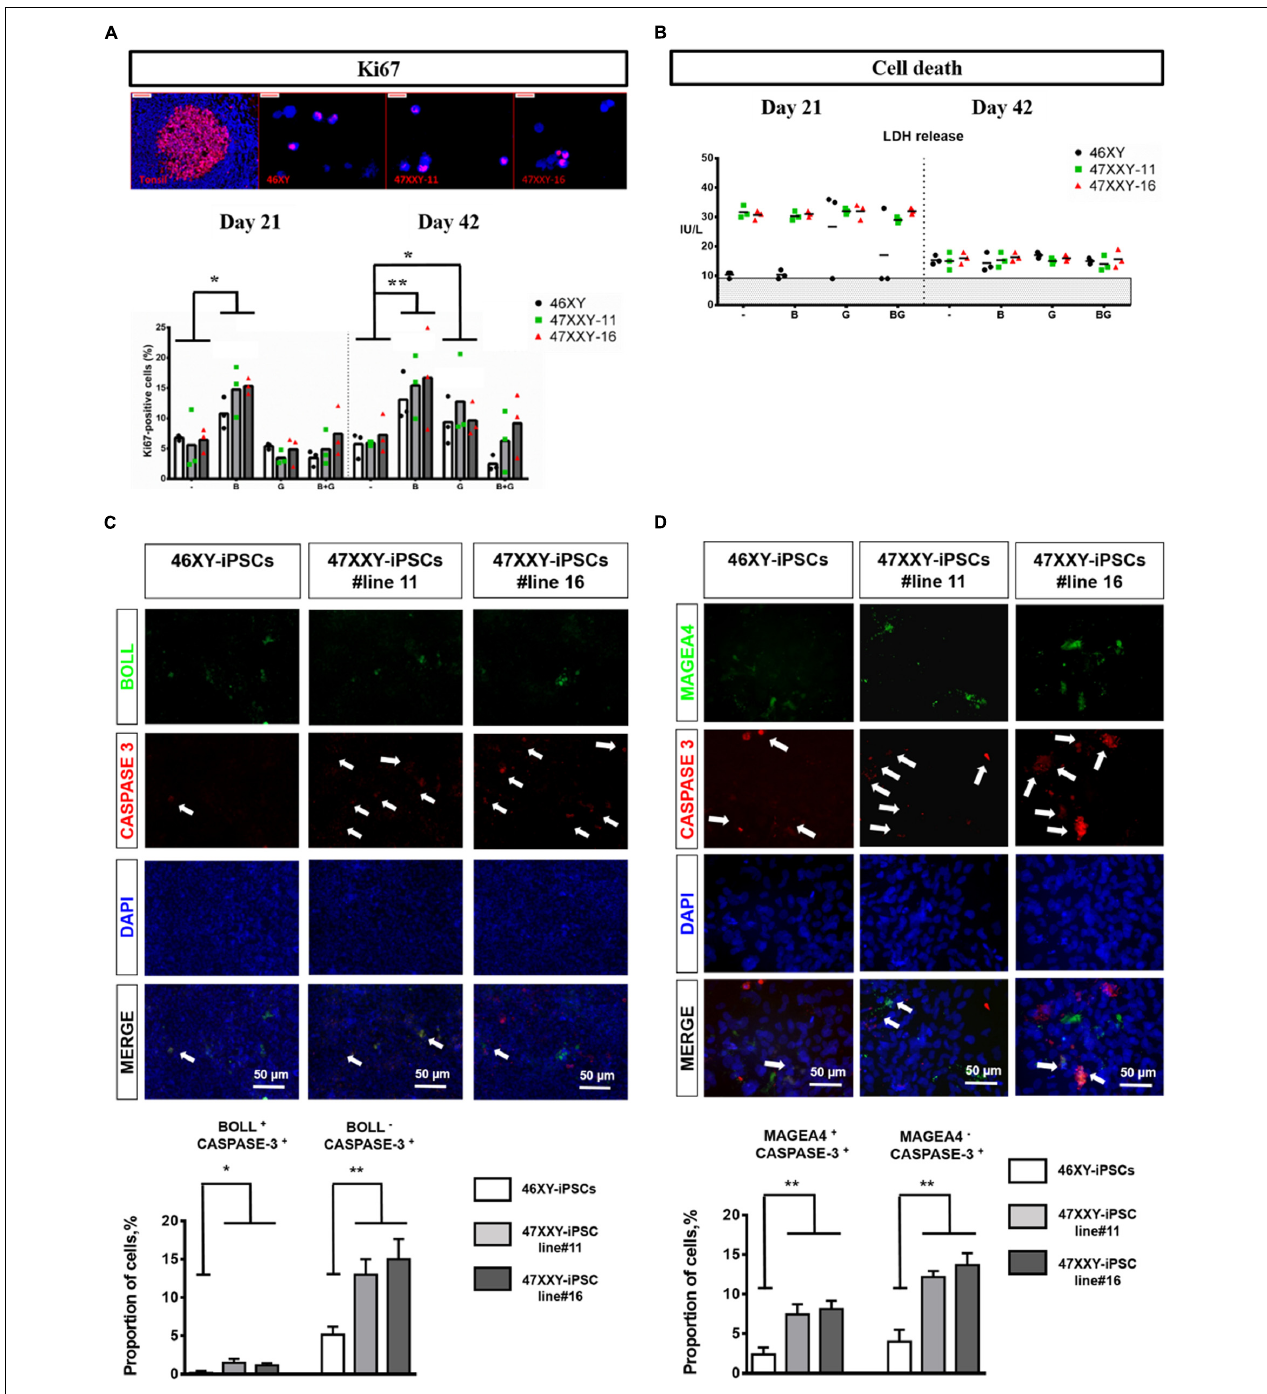
FIGURE 4 | Cell proliferation and cell death analysis of 46XX-iPSCs and 47XXY-iPSCs upon germ cell differentiation. (A) Cell proliferation analysis by Ki-67 staining of 46XY-iPSC- and 47XXY-iPSC-derived cells for each protocol after day 21 and day 42 of differentiation. (B) Cell death analysis by LDH release by 46XY-iPSC- and 47XXY-iPSC-derived cells for each protocol after day 21 and day 42 of differentiation. Data are represented as variance around mean, ∗ p < 0 . 05 and ∗∗ p < 0 . 01 between 46XY-iPSCs and 47XXY-iPSC line#11 and 47XXY-iPSC line#16 at day 21 and day 42, from n = 3 independent experiments. (C) Immunofluorescence co-staining of 46XY-iPSC- and 47XXY-iPSC-derived cells for the germ cell marker BOLL and the marker of apoptosis cleaved caspase-3. Quantitative analysis of the proportion of BOLL and cleaved caspase-3 double positive cells and the proportion of BOLL negative and cleaved caspase-3 positive cells at day 21 of germ cell differentiation. (D) Immunofluorescence staining of 46XY-iPSC- and 47XXY-iPSC-derived cells for the germ cell marker MAGEA4 and the marker of apoptosis cleaved caspase-3. Quantitative analysis of the proportion of MAGEA4 and cleaved caspase-3 double positive cells and the proportion of BOLL negative and cleaved caspase-3 positive cells, at day 21 of germ cell differentiation. Data are represented from n = 3 independent experiments.